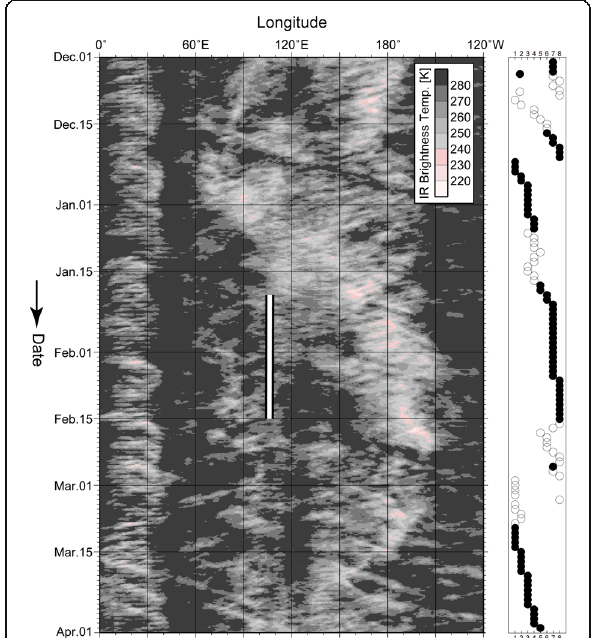
Fig. 2 Hovmöller diagram of the infrared brightness temperature in the Global-IR dataset (Janowiak et al. 2001) and averaged between 10° S to 10° N. The white vertical line indicates the longitudinal location of the array and the ASP. The right panel shows the MJO phase index by Wheeler and Hendon (2004), with solid/open circles for amplitude equal or greater than/less than 1.0,